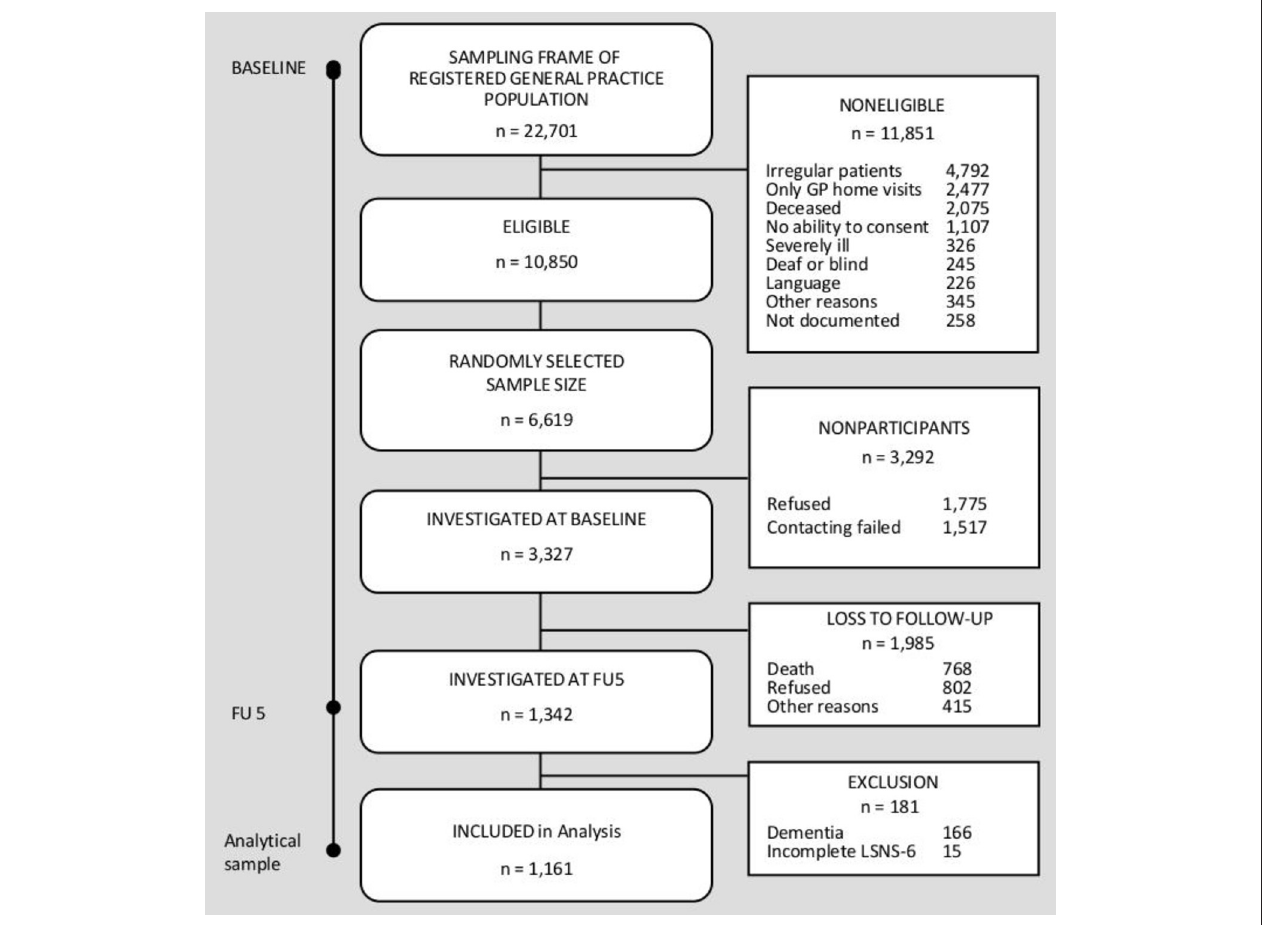
FIGURE 1 | Sample selection